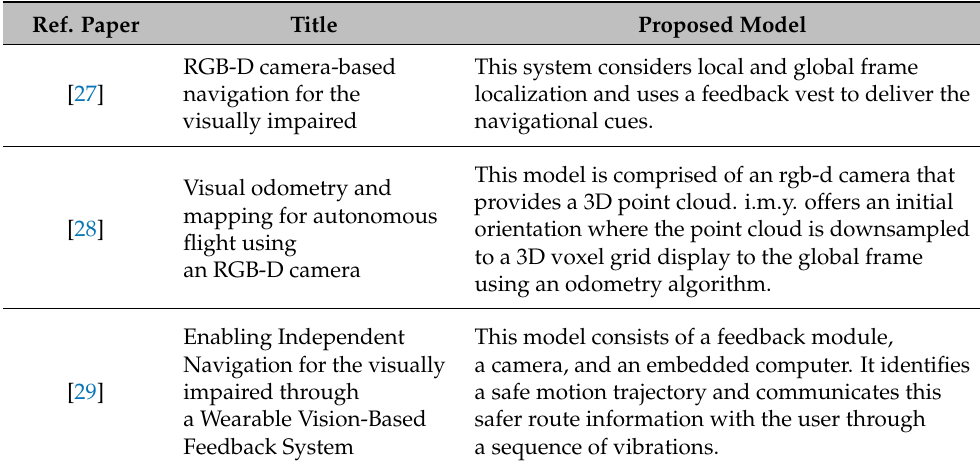
Table 2. Summary of Various Camera-Based Navigation